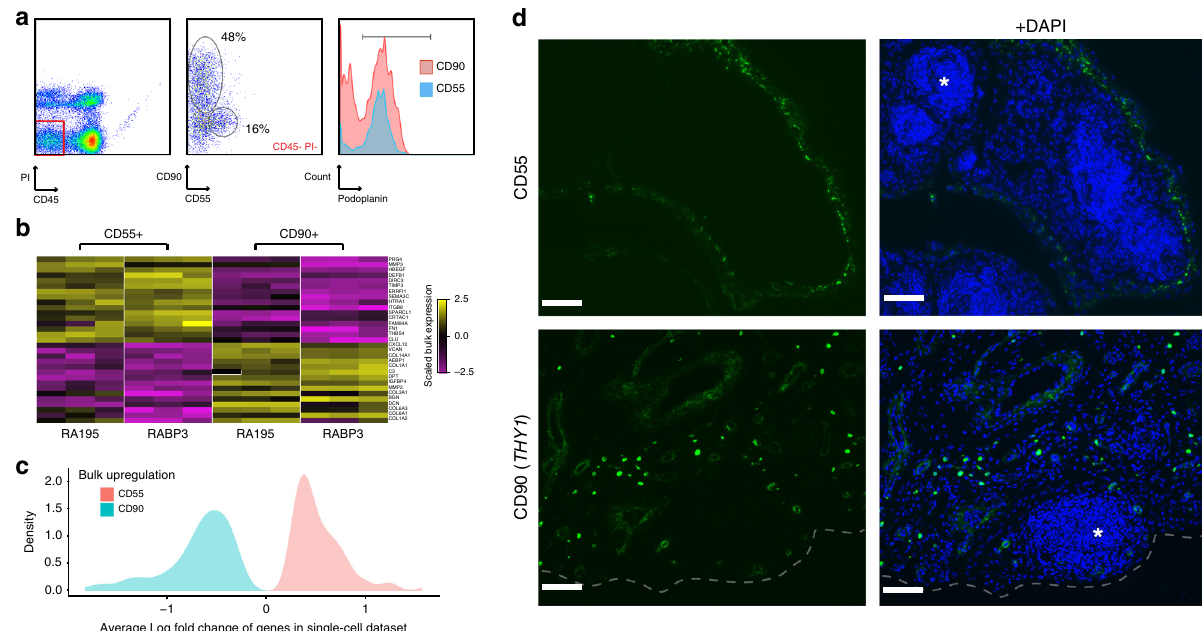
Fig. 5 Bulk RNA-seq and immuno fl uorescence of synovial fi broblast subtypes. a Cell surface expression of CD90, CD55 and podoplanin in synovial tissue. Synovial cells were gated on the CD45 − PI − population (left panel) and analyzed for the proportion of CD90+ and CD55+ cells (middle panel), and relative podoplanin cell surface expression (right panel). b Bulk RNA-seq of fl ow sorted CD55+ and CD90+ patient samples RA195 and RABP3. Heatmap shows that markers of fi broblast populations identi fi ed in scRNA-seq data (Fig. 4a) are strongly differentially expressed in bulk. A list of transcriptomic markers for each sorted sample is provided in Supplementary Data 2. c We identi fi ed genes that were differentially expressed between CD55+ and CD90+ fi broblasts in both the bulk and single-cell datasets. The density of average log fold changes observed for these genes in the single-cell data is colored by upregulation in the bulk data, demonstrating agreement between the bulk and single-cell datasets. d CD90 and CD55 localization in RA synovial tissue. Paraf fi n-embedded synovial tissue was sectioned and assayed for target markers by immuno fl uorescent staining with antibodies for CD90 (green) or CD55 (green) and counterstained with DAPI (blue). Lymphocyte in fi ltrates are denoted by gray asterisks. Images were acquired at 20 × magni fi cation. Scale bar is 100 µ